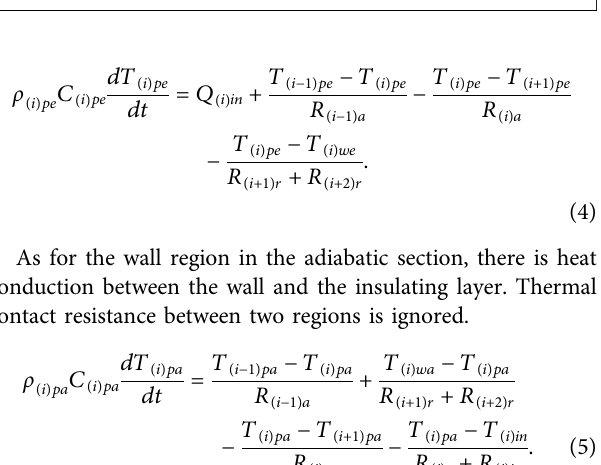
FIGURE 4 | Contact heat transfer between the wall and insulating